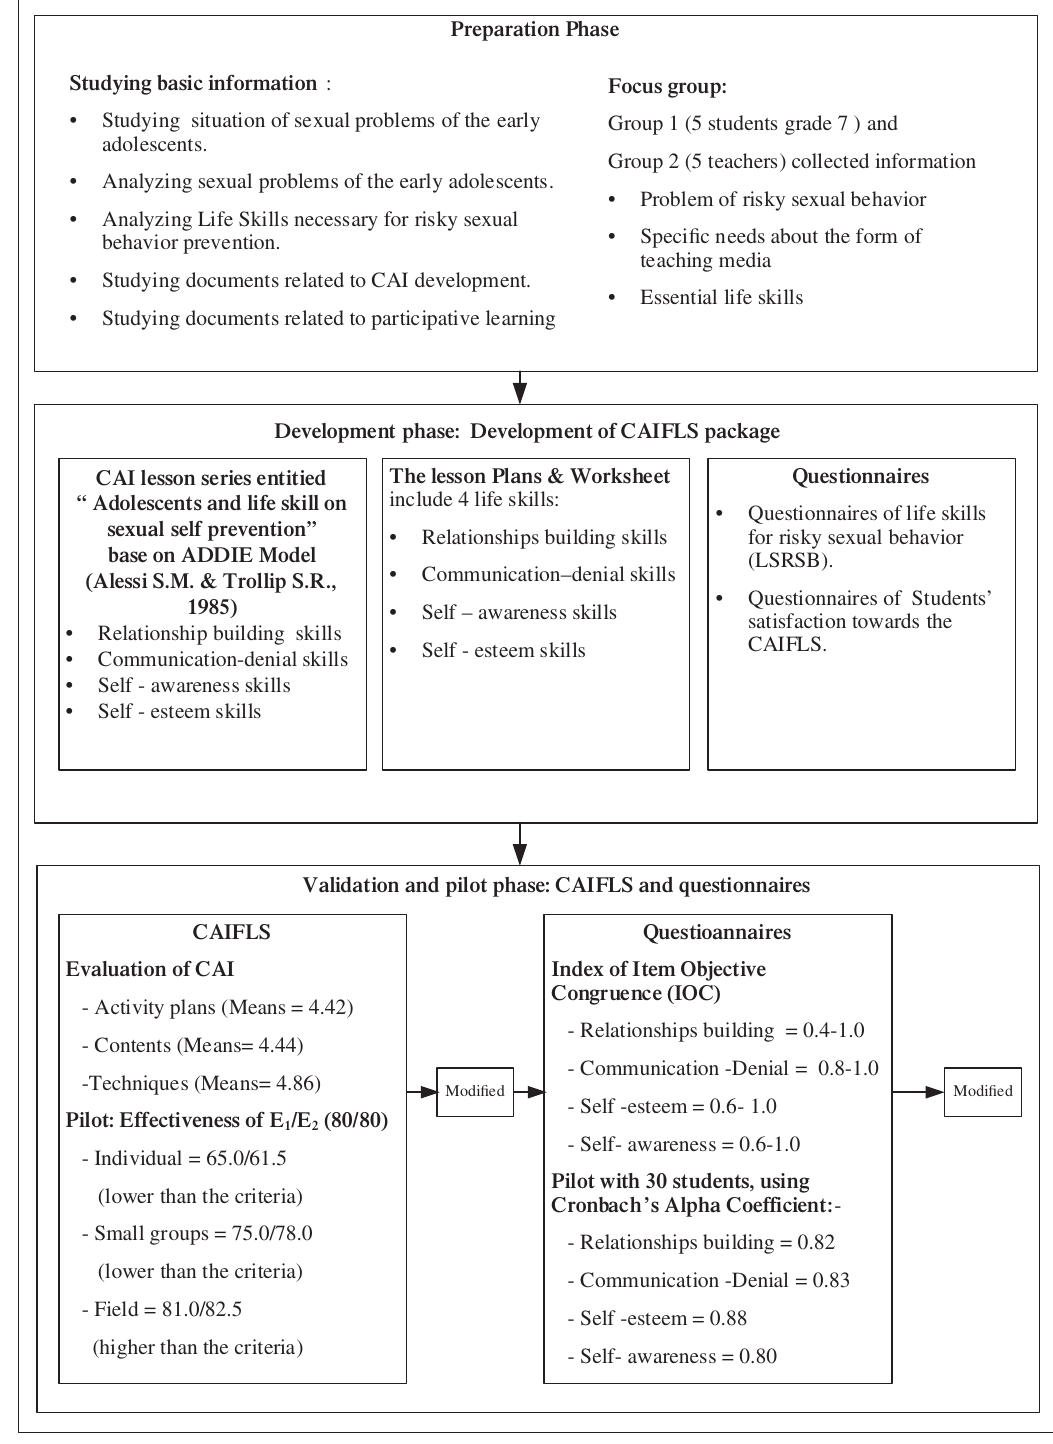
Figure 1. Phase 1: Development of the